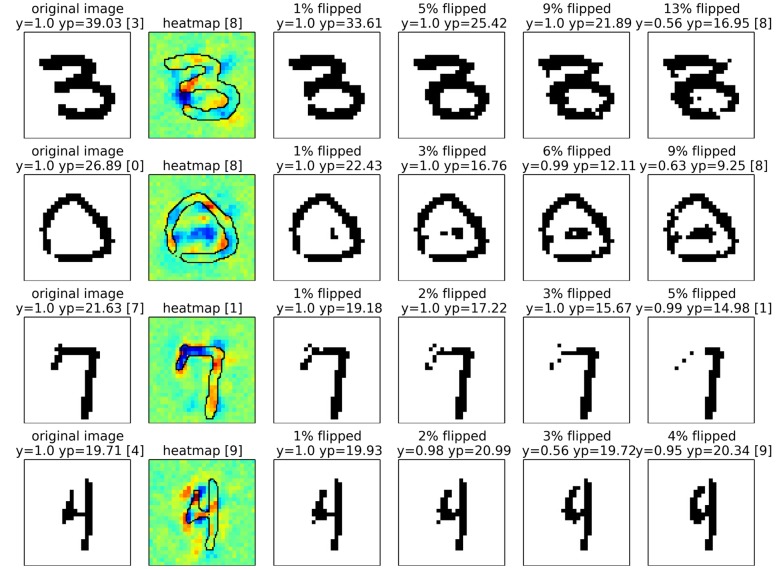
Examples of images with an increasing amount of flipped pixels and the corresponding predictions of the classifier.Here pixels are flipped towards the class label given in parentheses above the heatmap. Pixels were flipped in steps of 1% of all pixels until the predicted class label changed. The plots show the output of the softmax function y and the output score of the preceding linear layer yp. The pixels were sorted before flipping in increasing order of the pixel-wise score, i.e. lowest scoring pixels were flipped first. In this panel the heatmap was computed for a classifier which did not produce the highest score, i.e. for a random false class label. The originally predicted label is given on the leftmost image in parentheses, the predicted label after the switch of the prediction is given in the rightmost image.